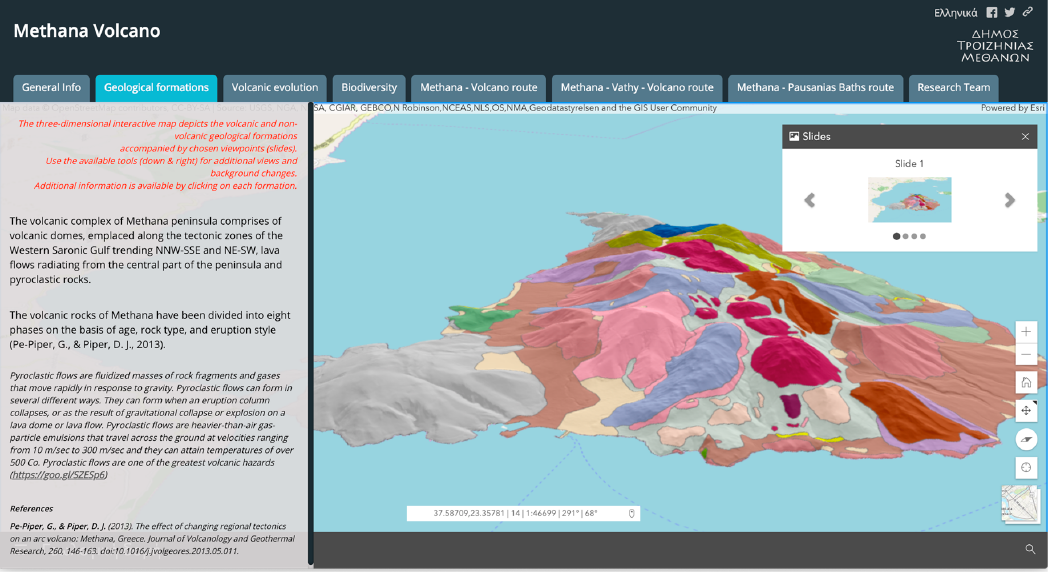
Figure 11. Screenshot of the second tab, where the geological setting of the peninsula is presented in 3D interactive map (https://goo.gl/ezFb4q).